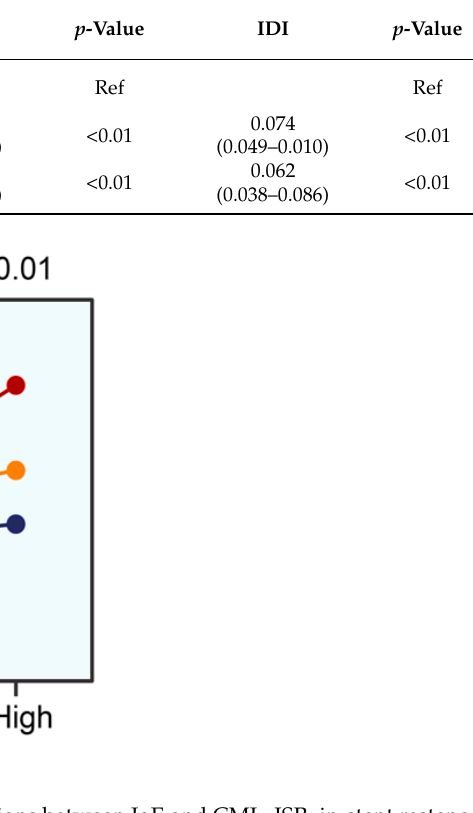
Figure 5. Percentage of ISR in relation to interactions between IgE and CML. ISR: in-stent restenosis. IgE and CML were analyzed as log-transformed continuous variables, ordinal vari- ables divided according to tertiles of IgE or CML, and as categorical variables using the lowest tertile as reference. Model 1: adjusted for age, sex, body mass index, smoking, dyslipidemia, and hypertension. Model 2: adjusted for age, sex, body mass index, smoking, dyslipidemia, and hypertension, HbA1c, LVEF, statin use, number of diseased vessels, class B2/C lesions, bifurcation lesions, CTO lesions, and stent diameter. As a continuous variable, OR is shown as per one SD (standard deviation). OR: odds ratio; HbA1c: glycated hemoglobin A1c; LVEF: left ventricular ejection fraction; CTO: chronic total occlusion. Established risk factors included age, sex, body mass index, smoking, dyslipidemia, hypertension, HbA1c, LVEF, statin use, number of diseased vessels, class B2/C lesions, bifurcation lesions, CTO lesions, and stent diameter. ISR: in-stent restenosis; NRI: